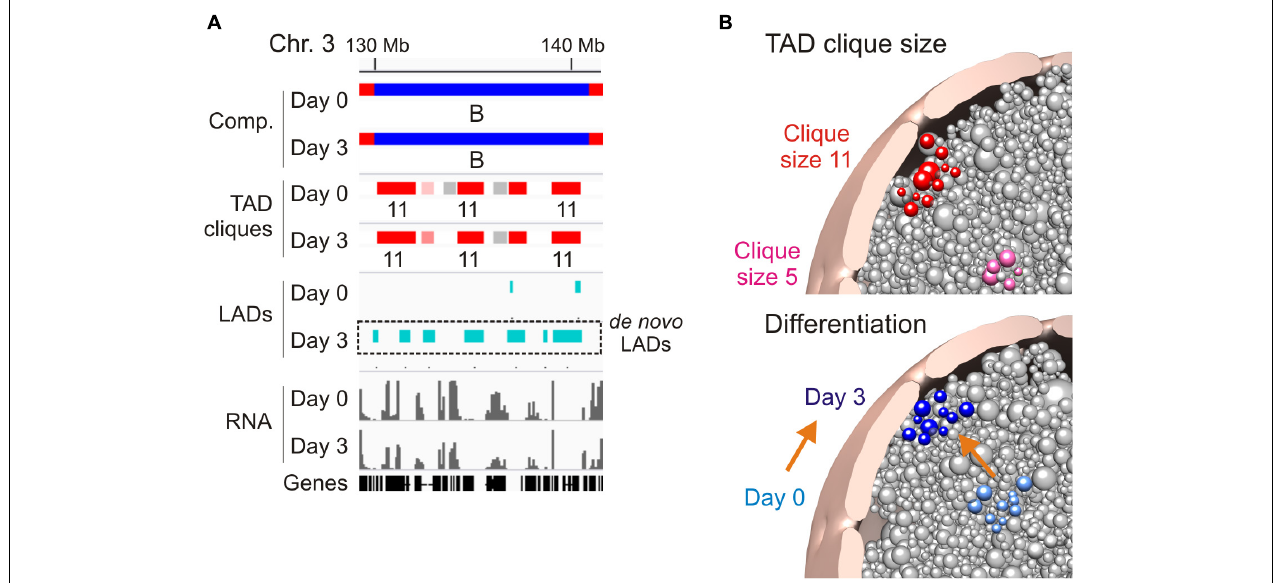
FIGURE 2 | Association of TAD cliques with the nuclear periphery. (A) Browser view showing de novo LADs appearing in pre-existing TAD cliques in a B compartment on day 3 of adipose differentiation. Sequence data can be accessed at NCBI GEO GSE109924 and GSE60237. (B) Radial positioning of TAD cliques in the nucleus: model views. Top , differential preferred radial position of a small (pink) and a large (red) TAD clique. Bottom , differentiation repositions a TAD clique toward the nuclear periphery; orange arrow symbolizes